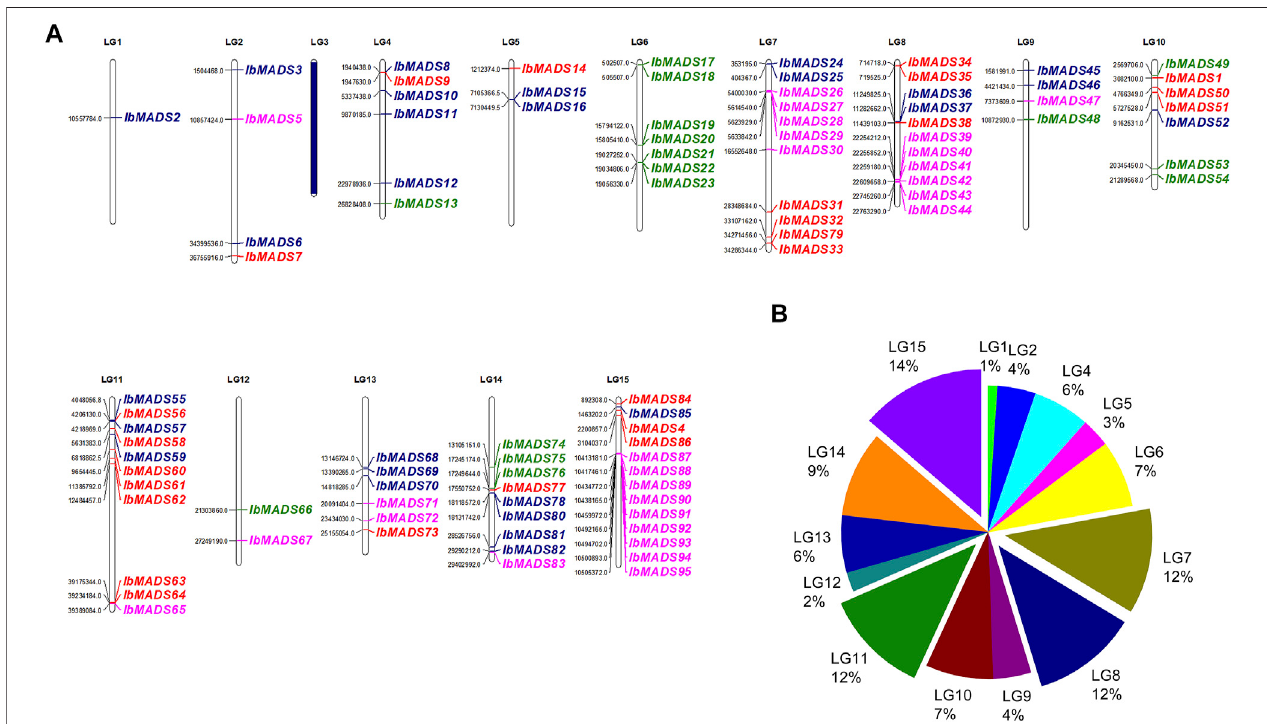
FIGURE 3 | Chromosome location (A) and distribution (B) of MADS-box gene in sweet potato. The purple name represents M α subfamily, the blue name represents M β subfamily, the green name represents M c subfamily, and the red name represents type II MADS-box genes. LG3 has no MADS-box gene distribution.